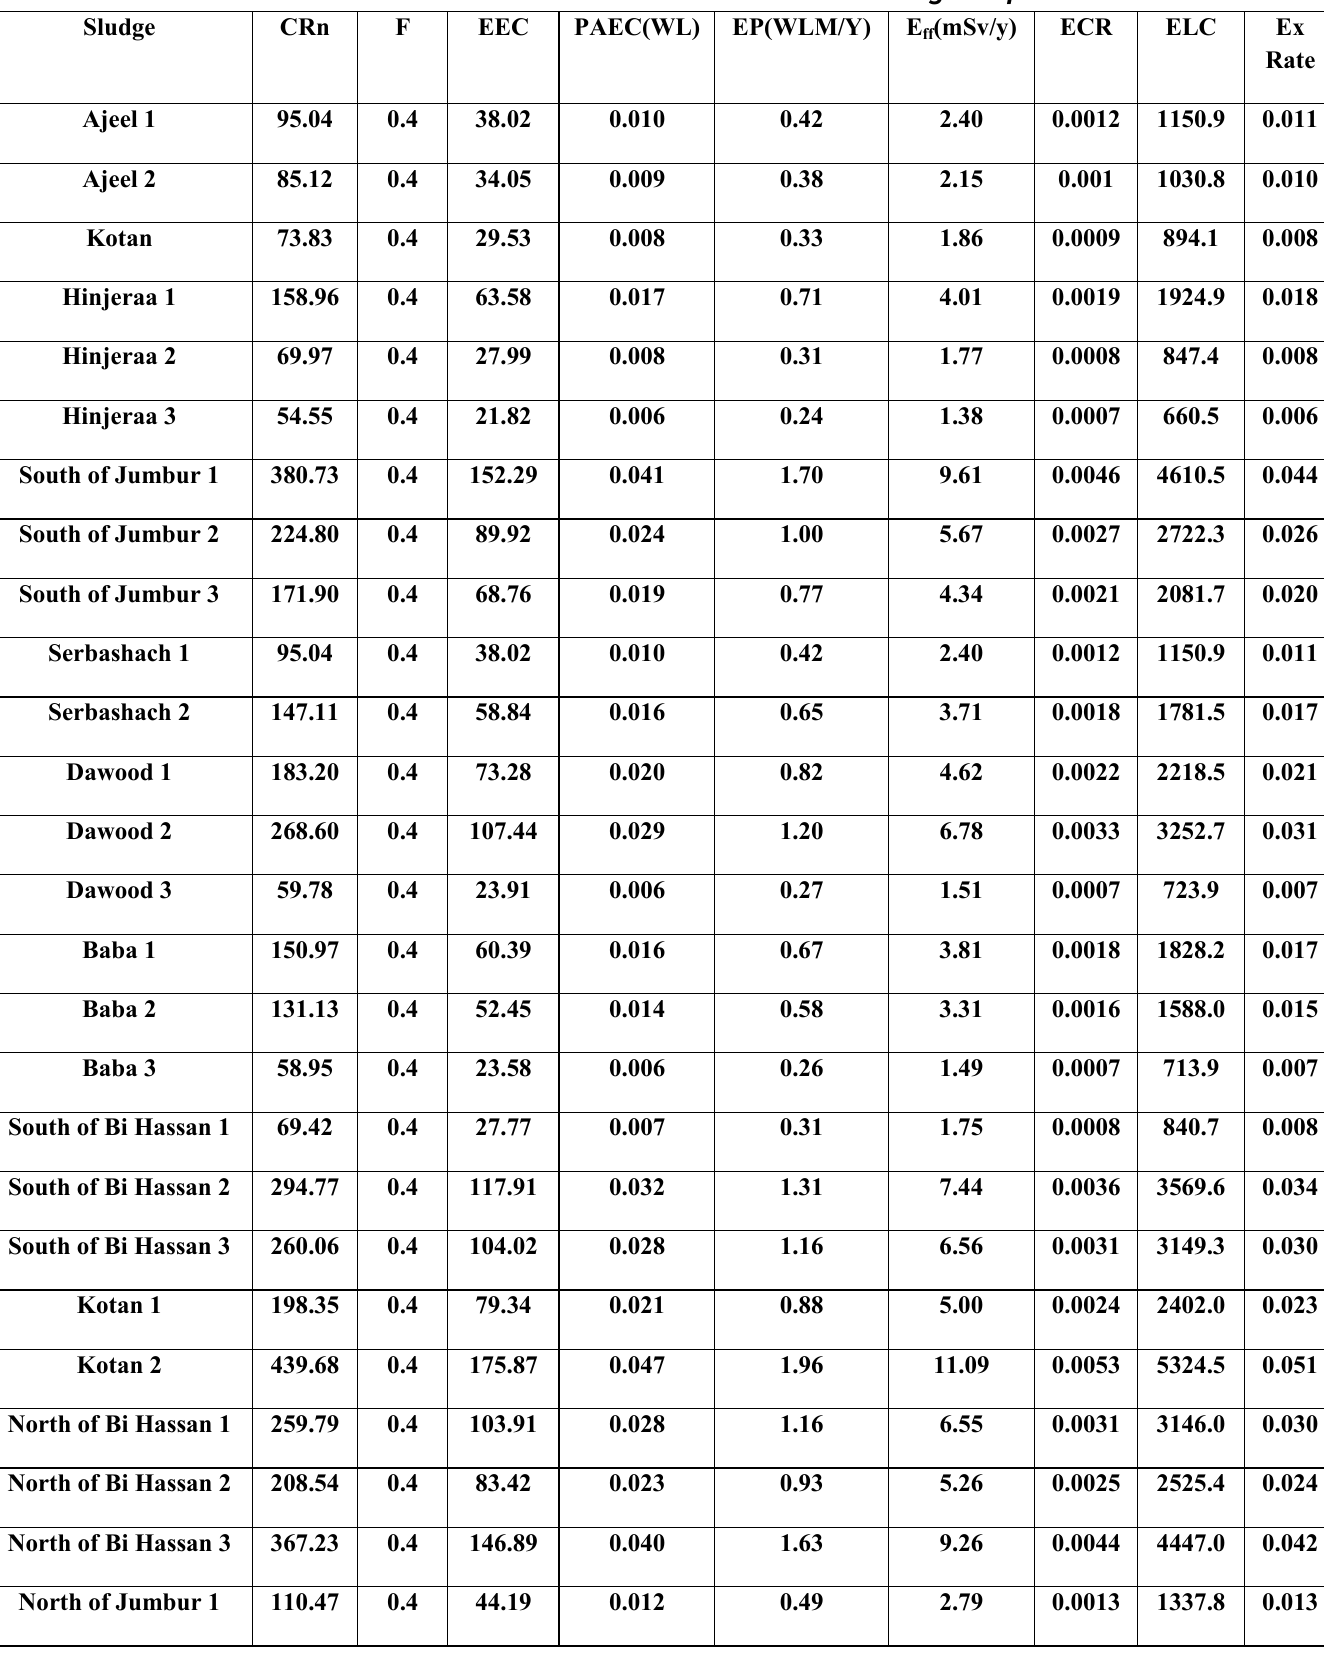
Table 2: The overall results of radon measurements of sludge